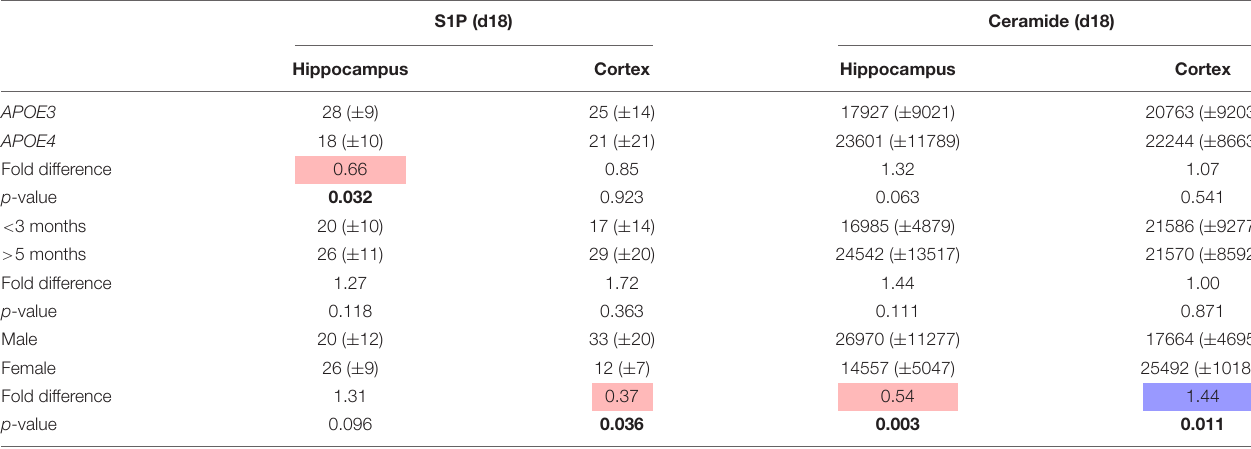
FIGURE 3 | Effect of APOE genotype ( APOE 4 vs. APOE 3), familial AD mutations (FAD vs. non-FAD), age ( > 5 mo vs. < 3 mo), and sex ( in hippocampus, cortex, cerebellum and in plasma of mice. Color-scale indicates the differences in sphingolipid levels; blue indicates up to 30-fold higher levels and red indicates up to 10-fold lower sphingolipid levels. P -values of significant differences after correction for multiple testing are indicated in the table, n.s., non-significant ( n = 45–76 mice per group). TABLE 2 | Effect of APOE genotype ( APOE4 vs. APOE3 ), age ( > 5 months vs. < 3 months), and sex (female vs. male) on S1P and ceramide levels (mean ± sd pmol/mg protein) in hippocampus and cortex of a selection of mice to validate study results ( n =